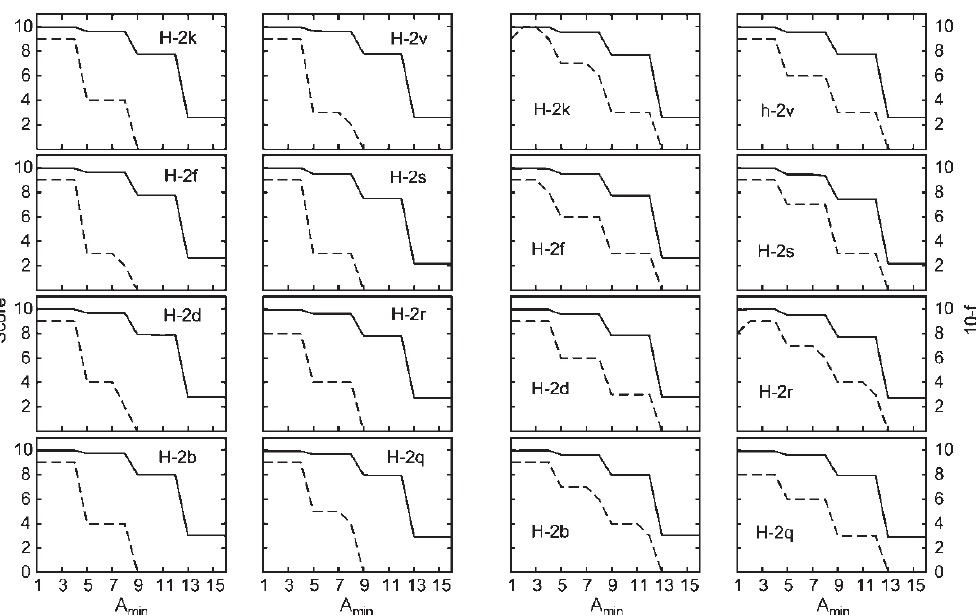
FIGURE 1 Comparison of each model’s predicted repertoires to the experimental ones, for eight different haplotypes. Left 2 columns: Sequential model, Right 2 columns: Two-step selection model. The predicted repertoires had been shaped for the case of four genes, Ly49a, Ly49g2, Ly49f and Ly49i; eachreceptorgenevaried inits binding affinity toits self-MHC-Iligand. Shownare (10– f ), f being the bestfit(solid lines), given instead of f itself inorder to show the correlation between fit and score; and the best score (dashed lines), for each set of parameters. These simulations were done in the inclusive mode. The best fit and highest score were obtained with the following parameter value sets: for H-2 b ð A min ¼ 3 ; A max ¼ 5 Þ and ð A min ¼ 4 ; A max ¼ 7 Þ ; for H-2 d ( A min ¼ 3 ; A max ¼ 3 or 5); for H-2 f ð A min ¼ 3 ; A max ¼ 5 Þ and ð A min ¼ 2 ; 4 # A max # 6 Þ ; for H-2 k ð A min ¼ 2 ; 4 # A max # 6 Þ and ð A min ¼ 3 ; A max ¼ 6 Þ ; for H-2 q ð